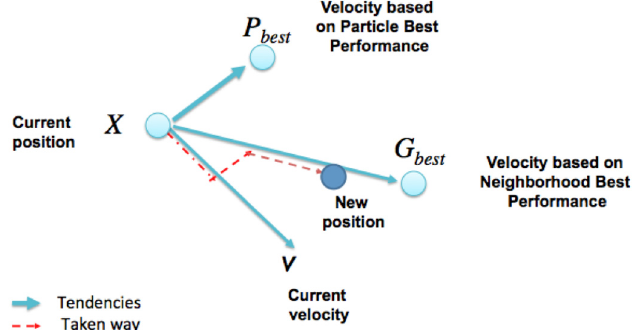
Fig. 1. The particle movement by basic PSO (proposed by [7]).